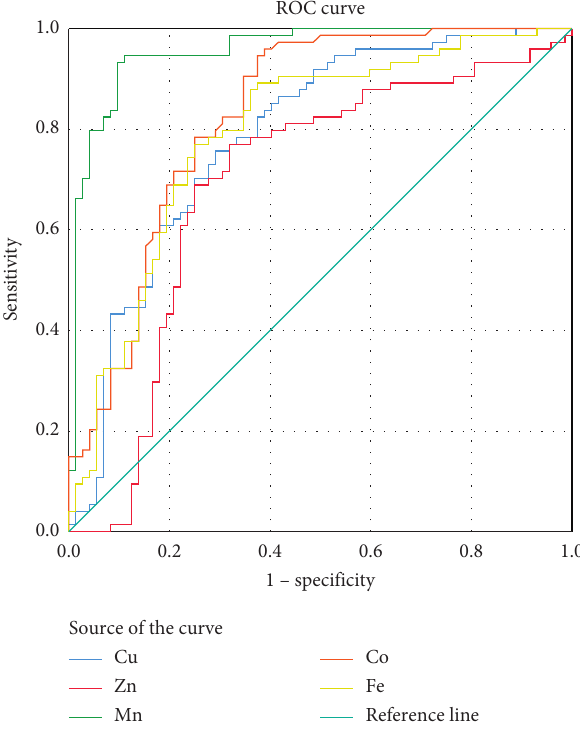
Figure 1: ROC curve analysis of the analyzed plasma metals for diagnosing